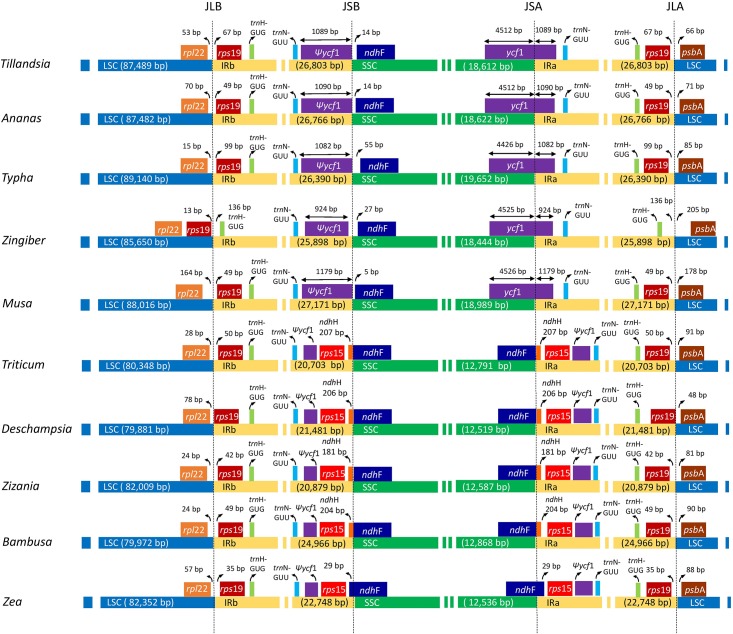
Comparison of plastid borders of LSC, SSC and IR regions among selected species of Poales.Selected genes or portions of genes are indicated by colored boxes. Gene and region lengths are not to scale (see Table 6).